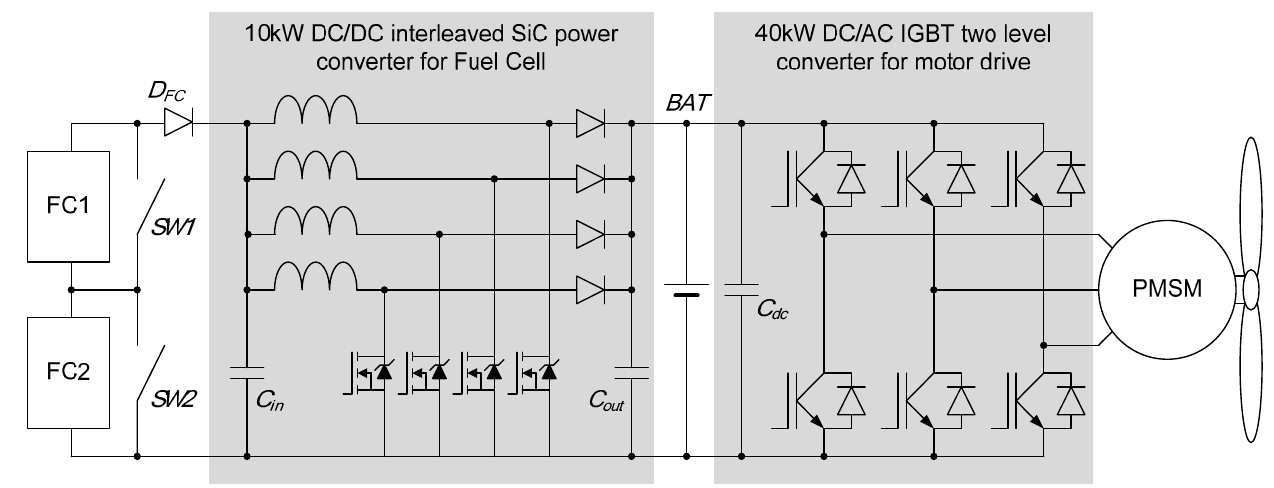
Figure 5. Scheme of the power conversion system with a DC/DC silicon carbide (SiC) power converter responsible for fuel cell loading and DC/AC insulated gate bipolar transistor IGBT converter responsible for feeding the propeller driving a permanent magnet synchronous motor.